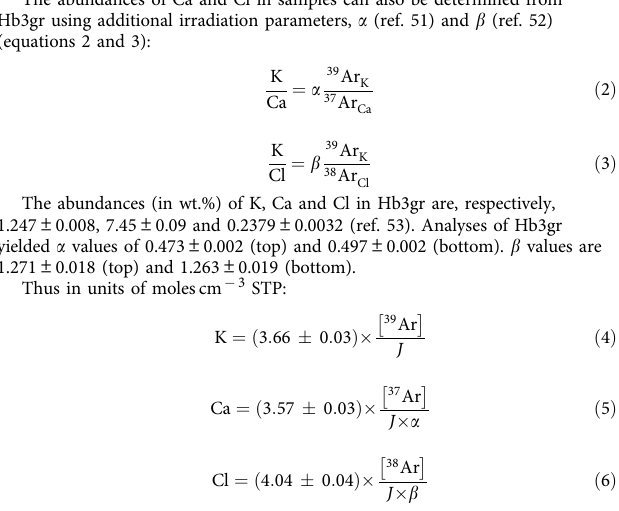
Supplementary Table 1. The 40 Ar/ 36 Ar ratios measured during the crushing and step-heating experiments are high (up to about 8,500) and cannot be solely explained by in situ decay of 40 K even during 4.5Ga. This 40 Ar excess, referred to as 40 Ar E hereafter, is correlated to the chlorine content (Figs 1 and 2) and probably linked to a hydrothermal fluid circulation through the samples 26 . One of the methods to correct the data for this 40 Ar E contribution is to use the K-Cl- 40 Ar (x-y-z) space where crushing and step-heating data would lie on a plane with the following equation (equation 7): K ; Cl where 40 Ar 36 36 Ar and 36 Ar are obtained during measurements (Supplementary Ar (cid:8) (cid:9) Table 1), 40 Ar 36 is the initial ratio trapped in the sample, A represents the Ar 0 correlation between 40 Ar E and the chlorine content, and B ( ¼ 40 Ar */ K) reflects the relationship between in situ produced 40 Ar ( 40 Ar * ) and the potassium content computed from the abundance of 39 Ar produced by neutron irradiation. The errors on the parameters of the plane defined by the data points were determined by a Monte Carlo propagation method using a Matlab code. First, for each point, coordinates on the x , y and z axes were divided by the mean error of the data set for normalization purpose. This was done to avoid overestimation of residuals resulting from different scale ranges (Supplementary Table 1). For each point a randomly generated cloud of 5,000 points was then created in order to properly represent the error envelop in the 3D space. The function of surface fitting ‘sfit’ of Matlab was applied to the 80,000 points. ‘sfit’ is a total least squares regression method through the entire cloud of points, the robust option permitting removal of outliers on an iterative basis based on least absolute residuals. Plots of residuals are shown in Supplementary Fig. 2. The fitting method led to a 40 Ar/K value of ð 1 Þ